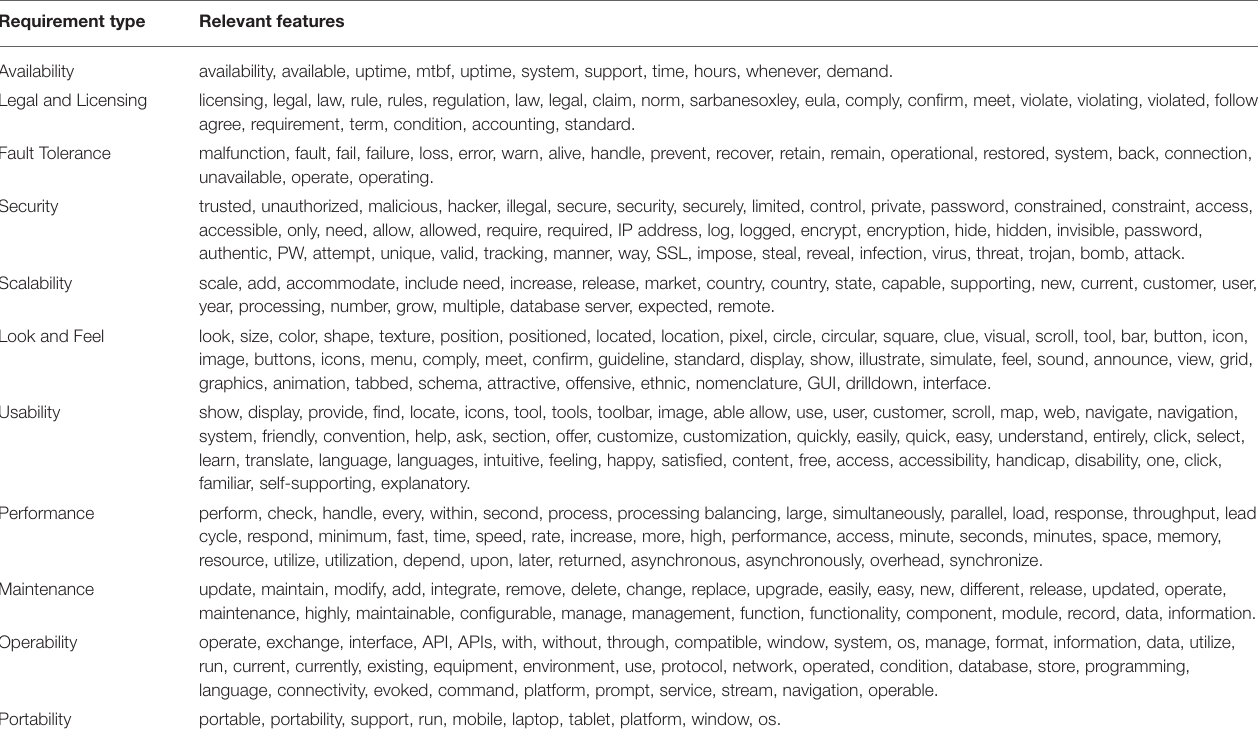
TABLE 4 | Additional relevant